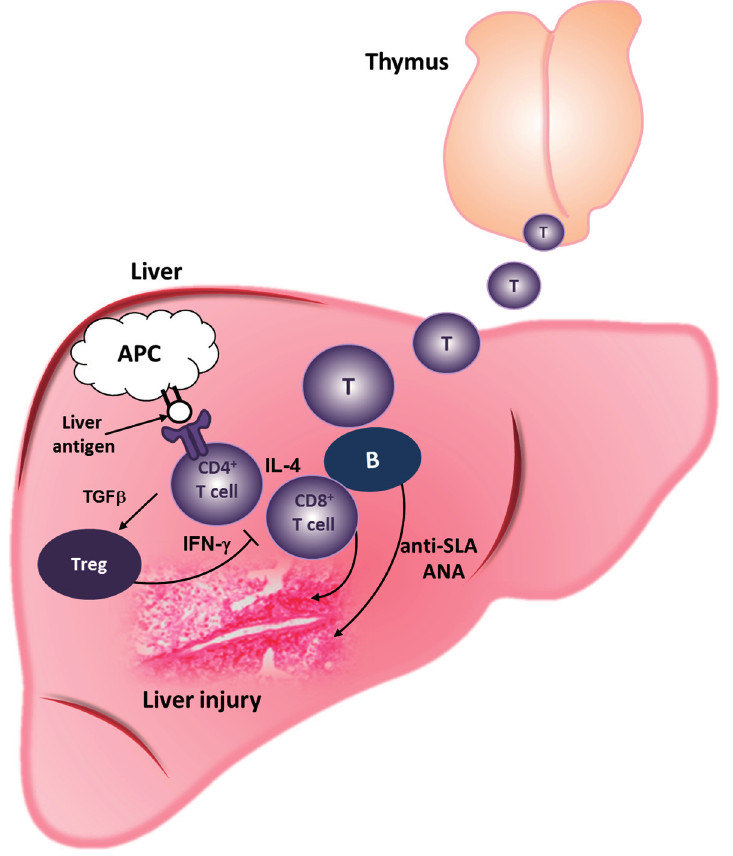
Figure 2. Working model of AIH induction in Traf6 ∆ TEC mice. mTEC depletion in